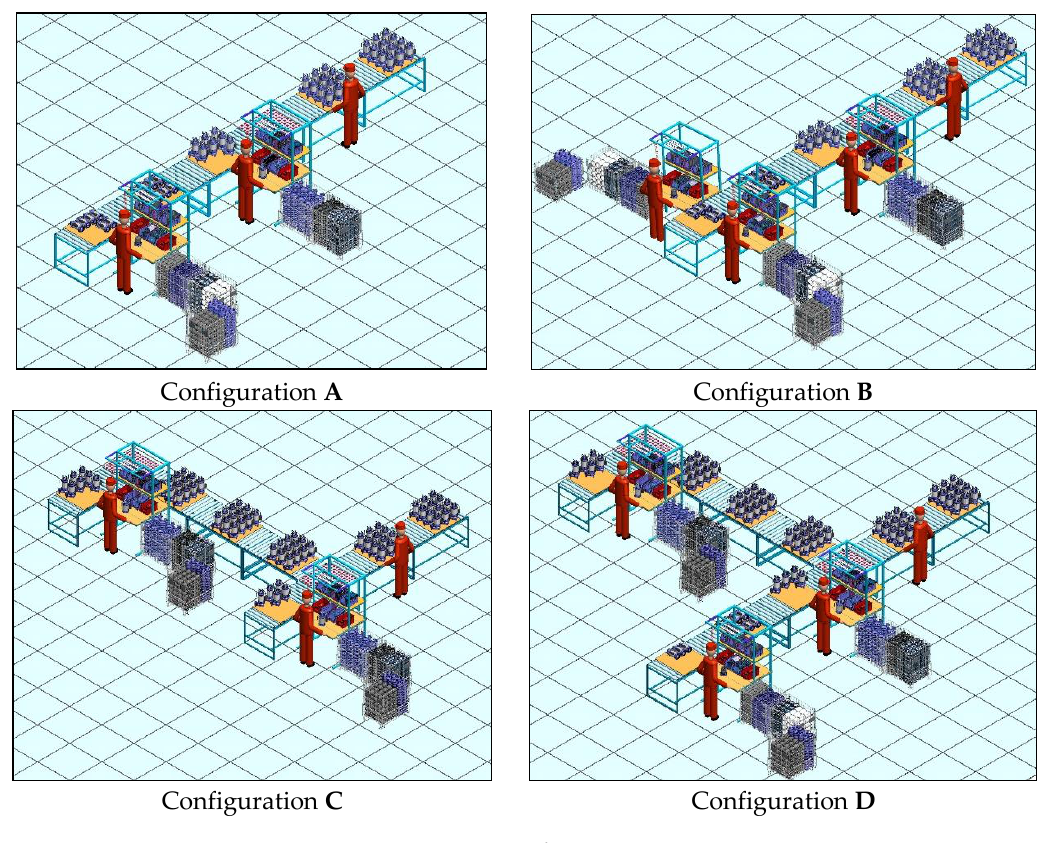
Figure 5. Configurations. Figure 5.